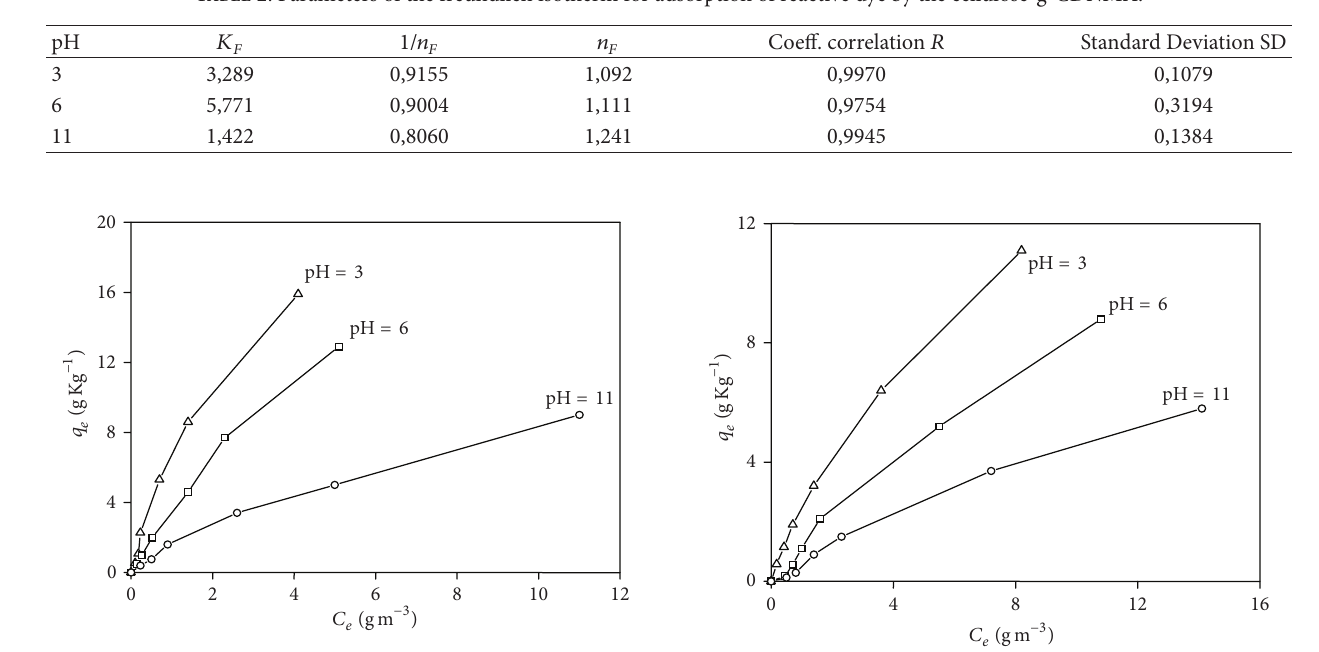
F 7: Equilibrium adsorption of methyl orange on the �bers